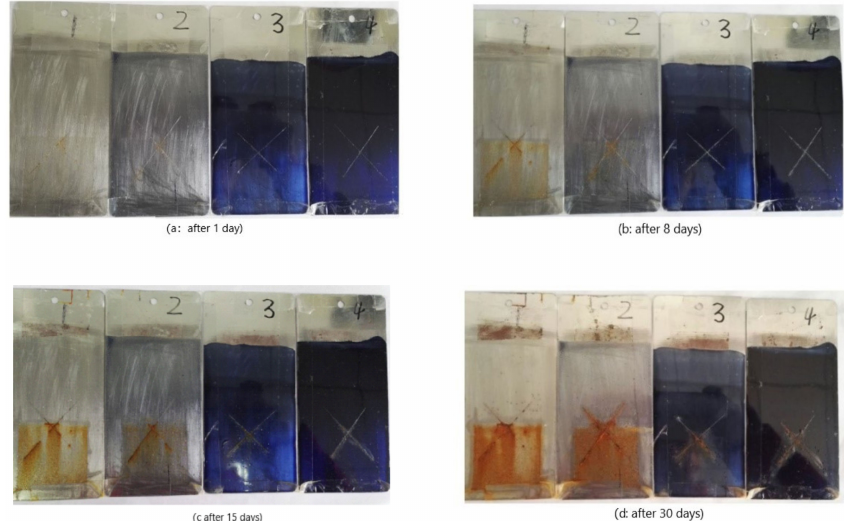
Figure 7. Corrosion behavior of epoxy coatings containing di ff erent content of AT after 3.5% NaCl solution immersion for di ff erent times(1: 0.0% AT, 2: 0.1% AT, 3: 0.5% AT, 4: 1.0% AT).